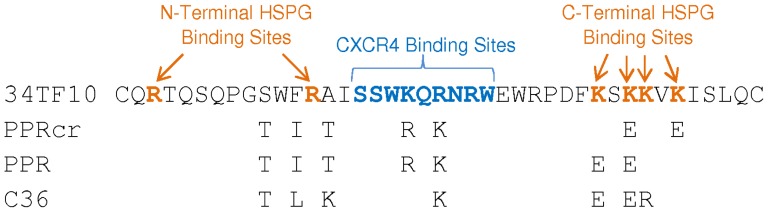
Sequence alignment of the V3 loop of 34TF10, PPRcr, PPR, and C36 surface glycoprotein.Blue indicates the CXCR4 binding region, and orange indicates the HSPG binding region. Both regions are indicated in bold.